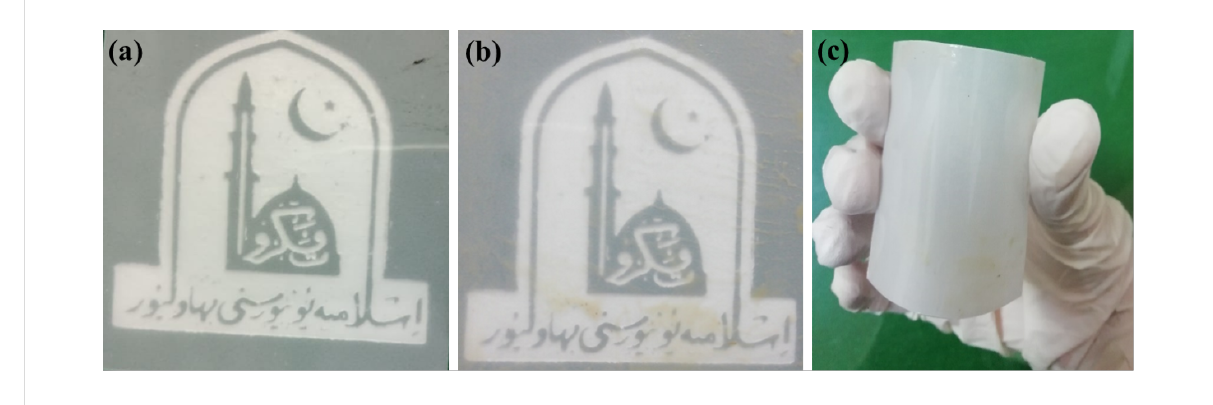
Figure 2: A print of the logo of “The Islamia University of Bahawalpur” behind (a) a PET film without ink coating and (b) a PET film with AgNW ink coating. (c) A photo showing the flexibility of the PET film after AgNW ink coating. These figures clearly depict that PET film retains its flexibility and